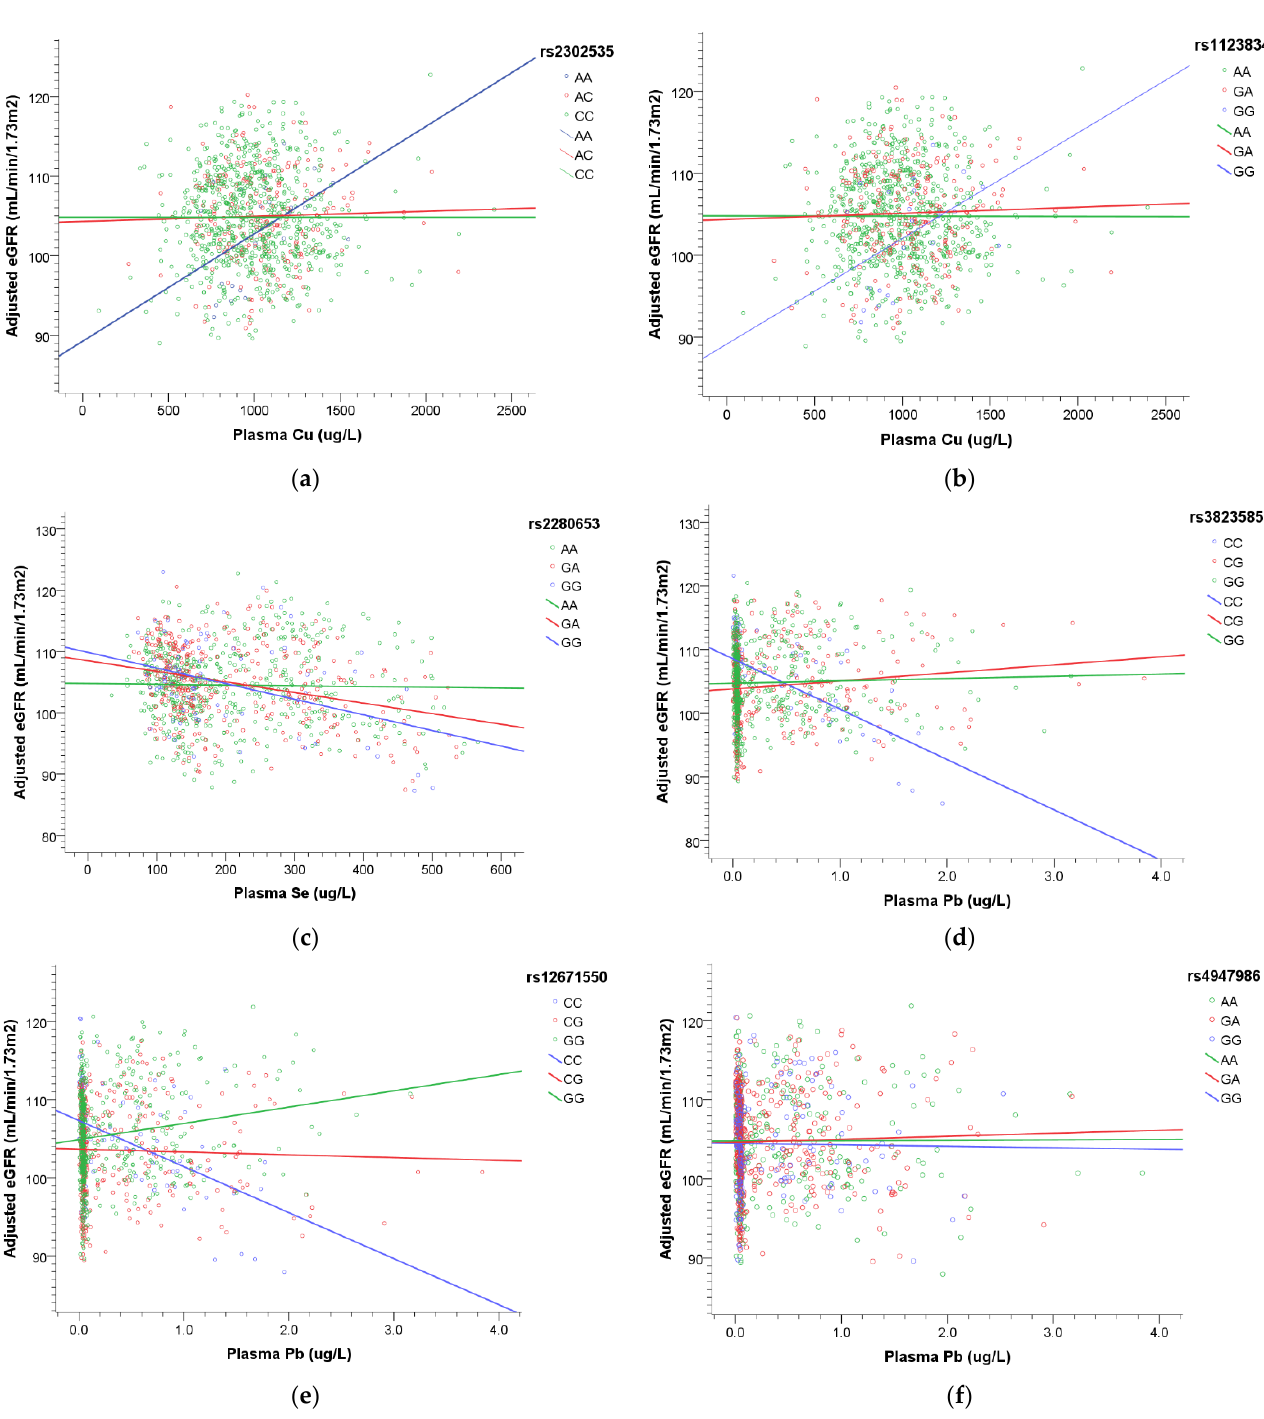
Figure 4. The association of plasma metals with renal function modified by SNPs. The regression model was built as eGFR = β 0 + β M, j M j + β SNP,1 i SNP 1 i + β SNP,2 i SNP 2 i + β int,1 i M j × SNP 1 i + β int,2 i M j × SNP 2 i + β c Covariates + ε . Adjusted covariates included age, gender, BMI, smoking, diabetes, and hypertension. ( a ) Increasing plasma Cu with elevated eGFR in rs2302535 AA genotype. ( b ) Increasing plasma Cu with elevated eGFR in rs11238349 GG genotype. ( c ) Increasing plasma Se with declined eGFR in rs2280653 GG and GA genotype, especially a steeper slope noted in GG genotype. ( d ) A declined eGFR was noted in rs3823585 CC genotype with increasing plasma Pb. ( e ) A declined eGFR was noted in rs12671550 CC genotype with increasing plasma Pb. ( f ) Increasing plasma Pb with mild decreased eGFR in rs4947986 GG genotype.